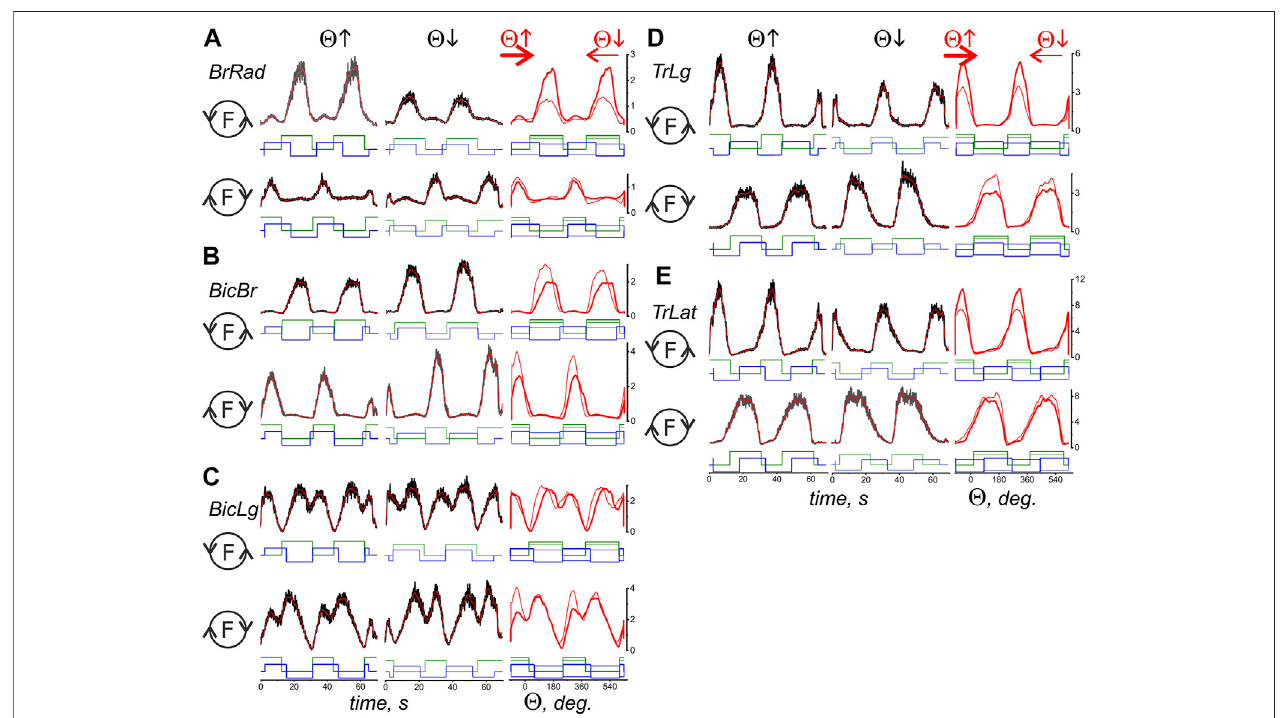
FIGURE 3 | Comparison of the average EMG activities in the fl exor and extensor muscles of the elbow joint during standard test movements produced during the creation of the hand force in opposite directions. The data were obtained of subject YK with identi fi ed bone geometry, repetition of six identical tests for averaging procedure.TheEMGreactionsontherising( Θ ↑ )andfalling( Θ ↓ )branchesoftheturninganglechangearecompared,andthecirclewiththeletterFinsidedesignatesthe force direction in the respective movement tests. The fi rst two columns present the time scale, thus including the averaged EMG records (black) with subsequent fi ltering by 300-point Savitsky-Golay smoothing (red lines); the fi ltered records are additionally transformed to depend on the turning angle and are superimposed in the third column; the thick and thin red lines correspond to the rising and falling branches of the turning angle, respectively. The stepwise records below the EMGs describe the timingofboth therespective force waves(green) and thedirectionsofthe musclelength changes(blue). The “ up ” and “ down ” onthe blue records correspondtothe lengthening and shortening movement phases, respectively. The thick EMG records in the third column evolve from left to right, whereas the thin records evolve in the opposite direction. The EMG intensities are calibrated based on % of the corresponding MVC values. A continuation of the presentation of this experiment for the shoulder muscles is shown in Figure